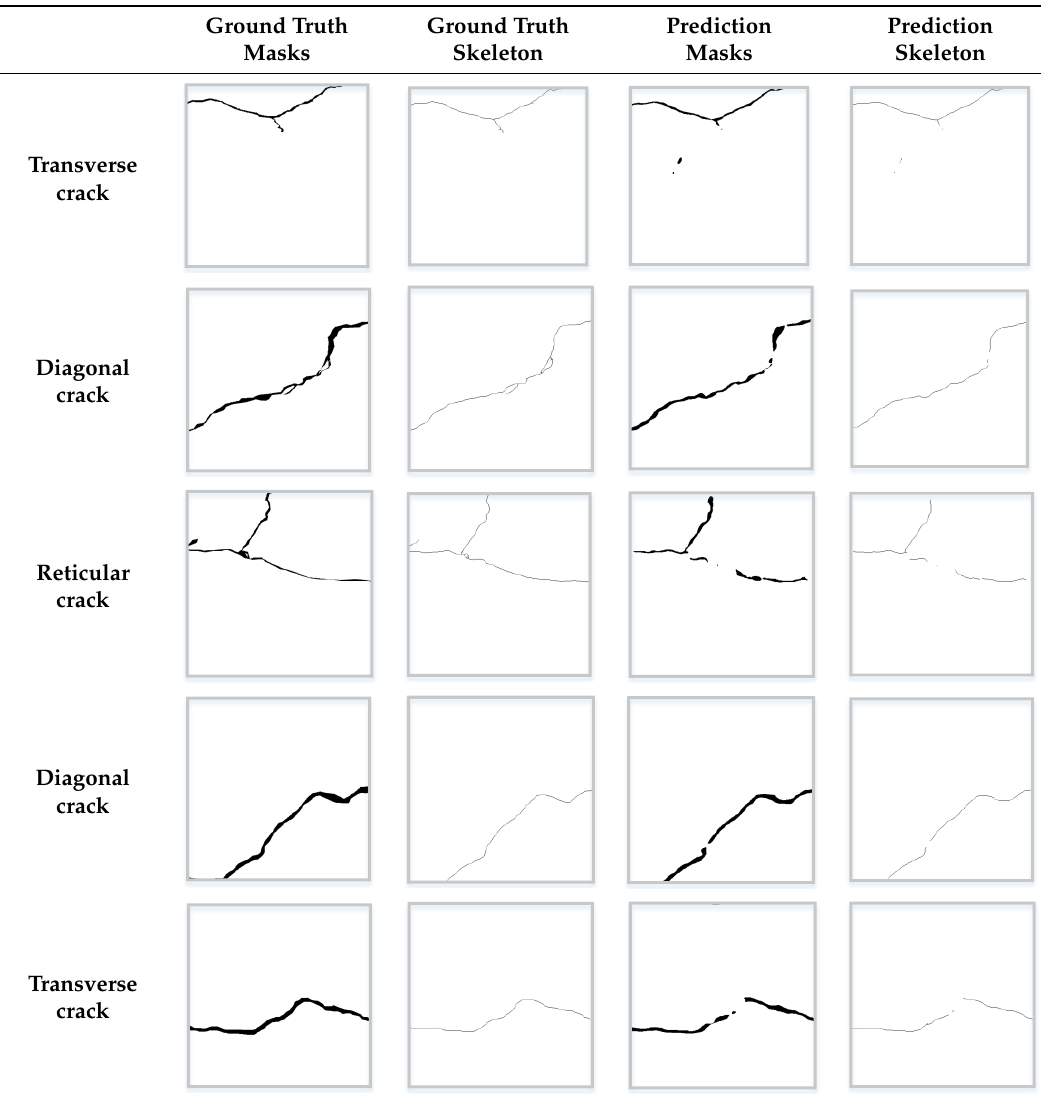
Table 7. Crack skeleton extraction of ground truth and prediction results.